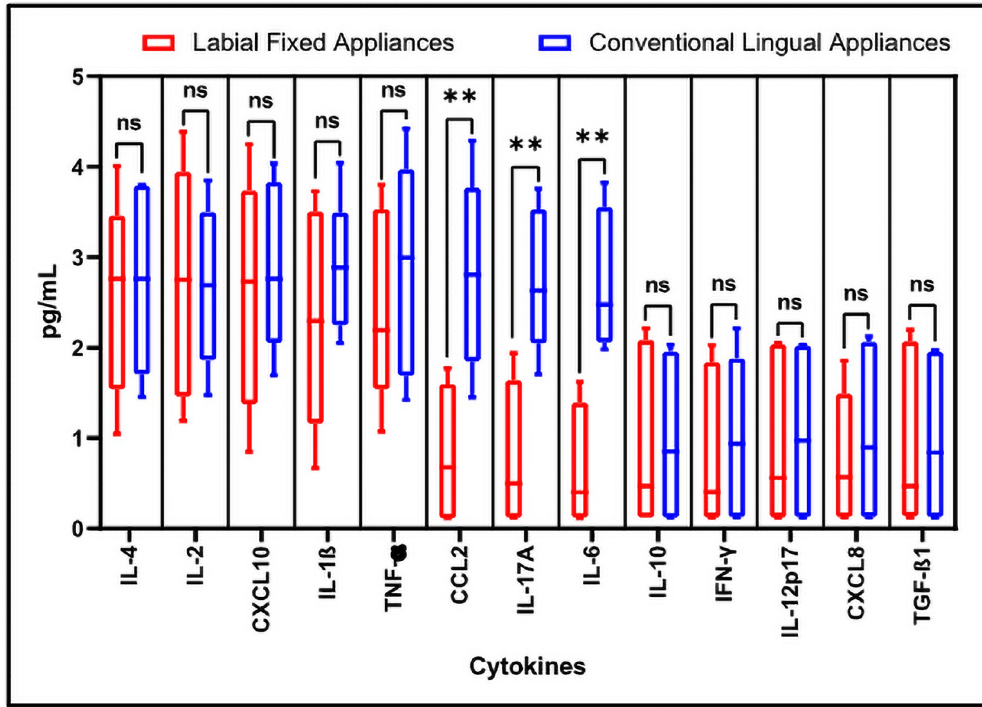
Fig 1. Flow cytometry-based analysis of human cytokines. The quantitation and comparative analysis of cytokines in the salivary samples was assessed by bead-based immunoassay on flow cytometer. Here, ns = non-significant, � p < 0.05, �� p < 0.001. IL-4: Interleukin 4, IL-2: Interleukin 2, CXCL10: C-X-C motif chemokine ligand 10, IL-1 β : Interleukin 1 beta, TNF- α : Tumour necrosis factor alpha, CCL2: C-C motif chemokine ligand 2, IL-17A: Interleukin 17A, IL-6: Interleukin 6, IL-10: Interleukin 10, IFN- γ : Interferon gamma, IL-12p70: Interleukin 12, CXCL8: Interleukin 8, TGF- β 1: Transforming growth factor beta 1.